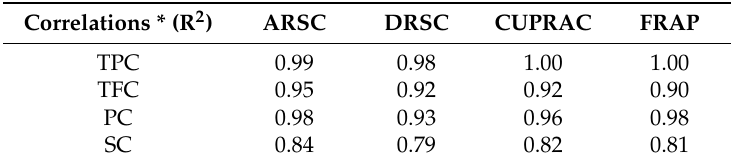
Table 3. Antioxidant activity of carrot peel dried at various conditions ( n = 3). ARSC DRSC CUPRAC FRAP Drying Method (mg TE/g DS) (mg TE/g DS) (mg TE/g DS) (mg TE/g DS) HAD50 nd 17.99 ± 4.26 c 4.73 ± 0.36 cd 16.20 ± 0.94 cd HAD100 nd nd 1.88 ± 0.16 e 9.56 ± 0.33 e VCD50 nd 3.51 ± 0.24 d VCD100 nd 1.16 ± 0.04 d 85.70 ± 3.71 b 21.67 ± 1.18 c